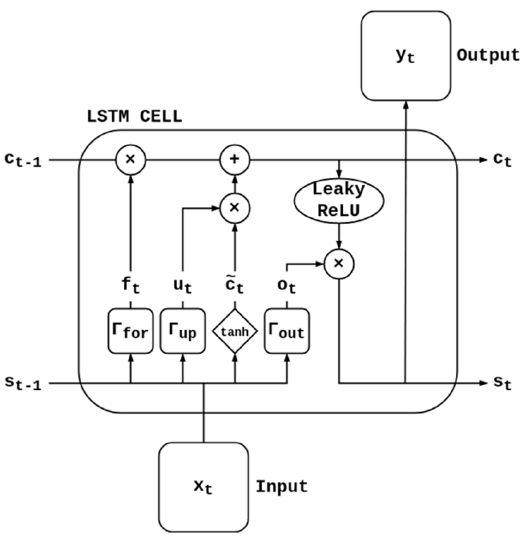
Figure 5. Structure of a long short-term memory cell [12].